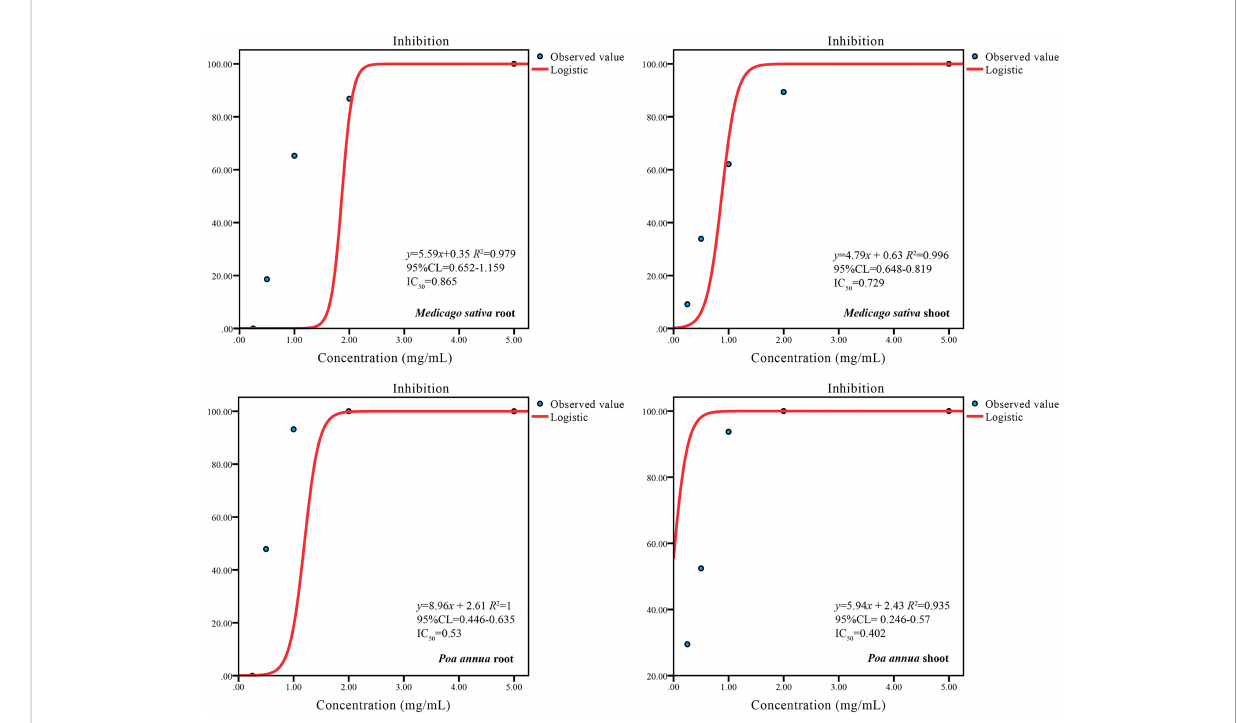
FIGURE 2 Dose – response curves of A. tibetica EO on seedling growth of M. sativa and P. annua . R 2 adj: adjusted coef fi cient of determination. IC 50 : 50% inhibit concentration of bested plants. 95% CL: 95% con fi dence limits.